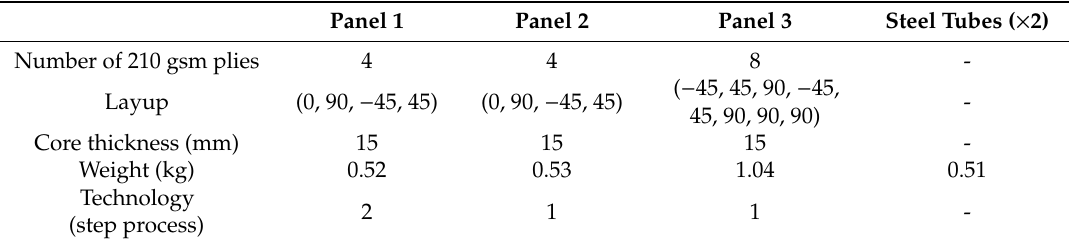
Table 2. Tested panels and tubes